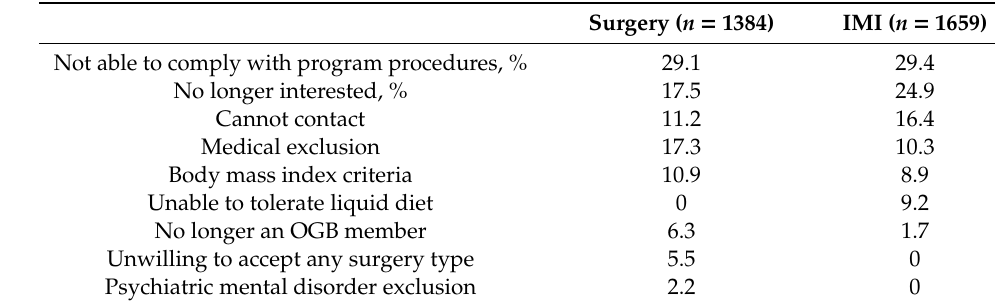
Table 2. Screening ineligibility